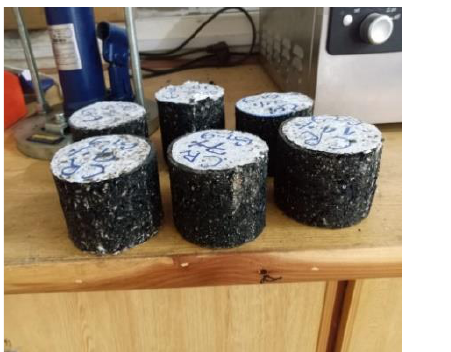
Table 6. NHA specifications for Marshall Parameters.